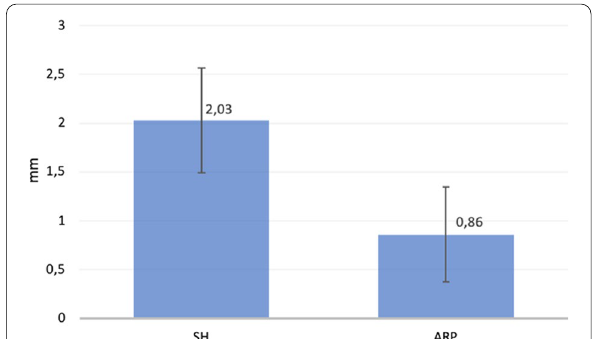
Fig. 7 Mean comparison of horizontal bone change at Horizontal Width 1 (HW-1) from baseline